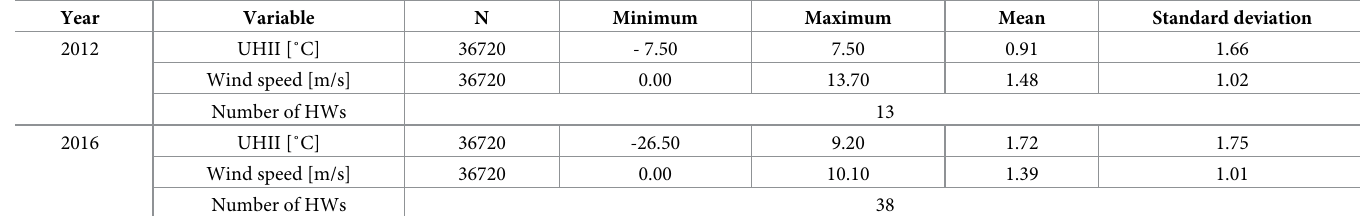
Table 2. Descriptive statistics of the data used in the